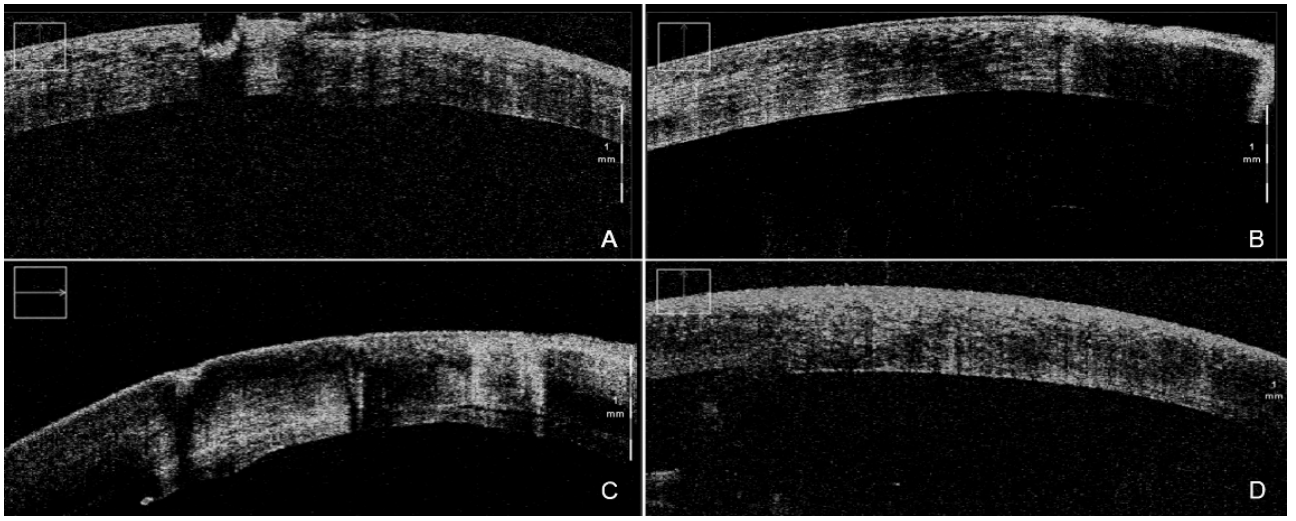
Figure 2 . iOCT-assisted DSAEK performed by an expert surgeon. During DM stripping, iOCT aided debris visualization ( A ) in order to obtain the smoothest possible dissection plane ( B ). After the implantation of the graft, iOCT was able to identify even the smallest persisting interface fluid ( C ), thus allowing for complete apposition of the graft, clearly visible at the end of the surgery ( D ). iOCT = intra-operative optical coherence tomography; DSAEK = Descemet stripping automated endothelial keratoplasty; DM = Descemet